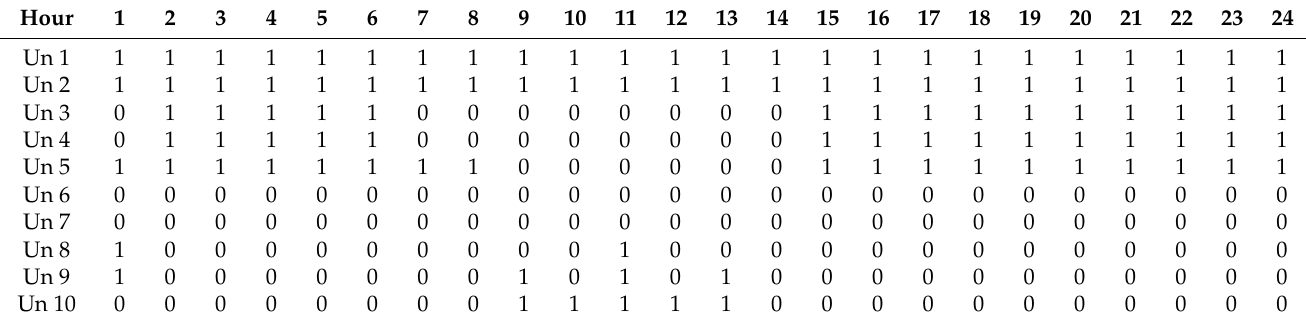
Table 11. Optimal scheduled operation for the 10-unit system over 24 h (test system 2).